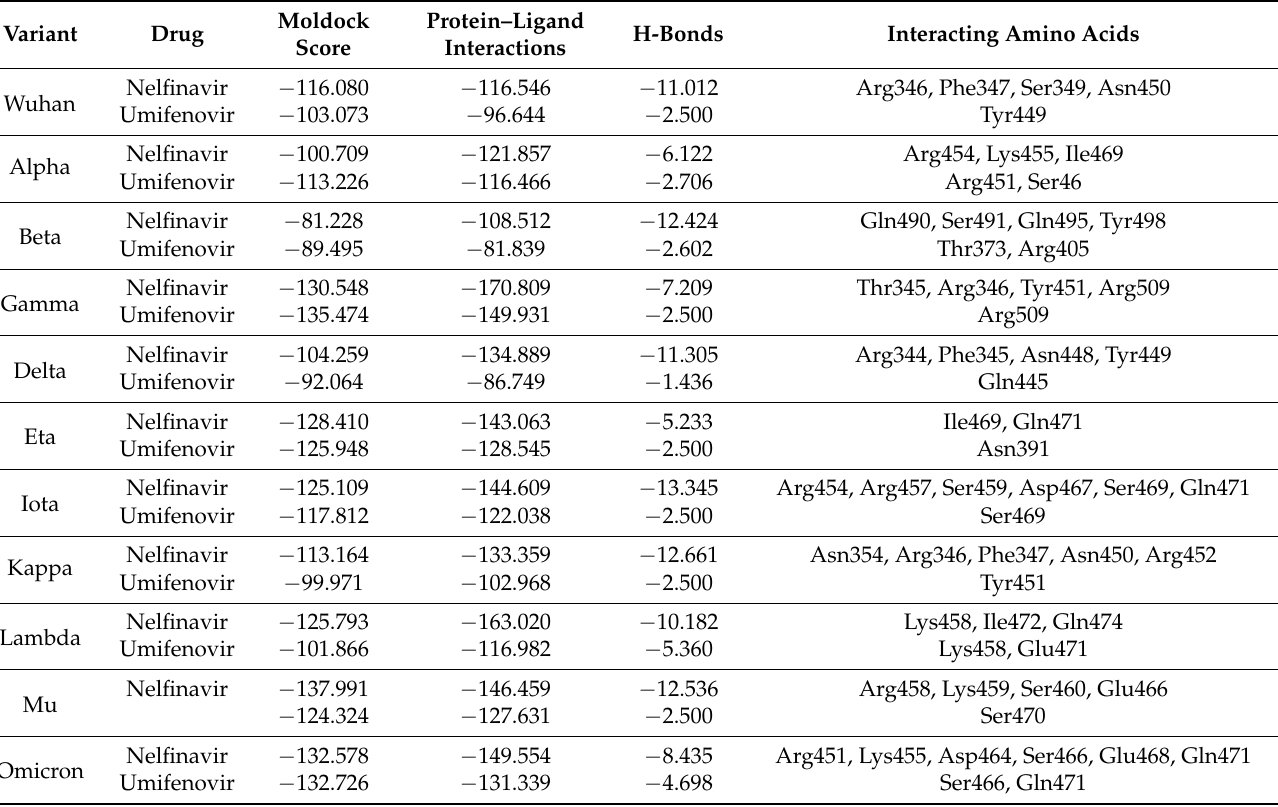
Table 2. Docking of nelfinavir and umifenovir to the S1 protein of different SARS-CoV-2 variants.